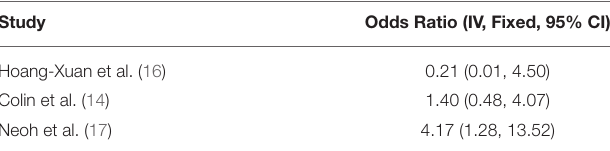
TABLE 3 | Results of comparing treatment failure in herpes zoster ophthalmicus patients treated with Oral Acyclovir 7 vs. 14 Day Course, Oral Acyclovir vs. Oral Valaciclovir, and Topical Acyclovir vs. Oral Acyclovir.